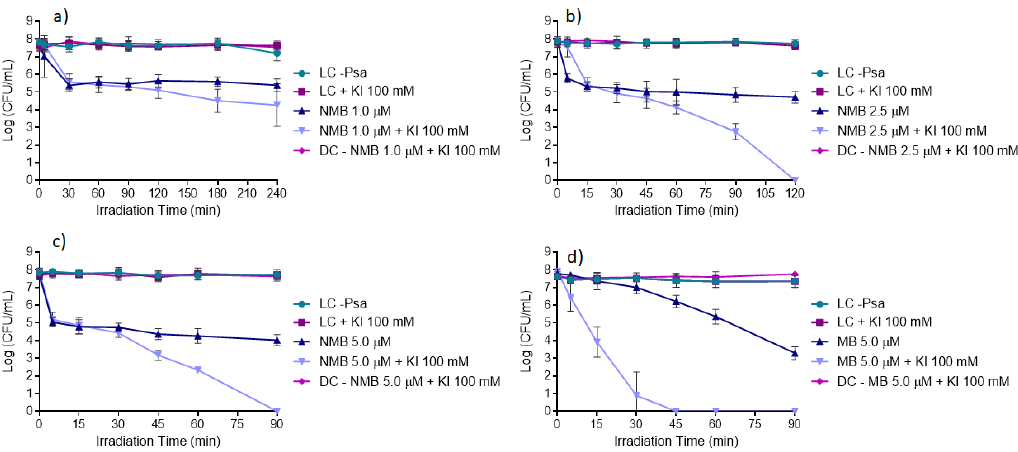
Figure 7. In vitro inactivation of Psa CRA-FRU 8.43 via aPDT, using NMB at: ( a ) 1.0 µ M; ( b ) 2.5 µ M; and ( c ) 5.0 µ M; and ( d ) MB at 5.0 µ M as photosensitizers, in the absence and presence of KI (at 100 mM). Values represent the mean of three independent assays in triplicate; error bars represent the standard deviation. LC, light control; DC, dark control. Lines just combine the experimental points.